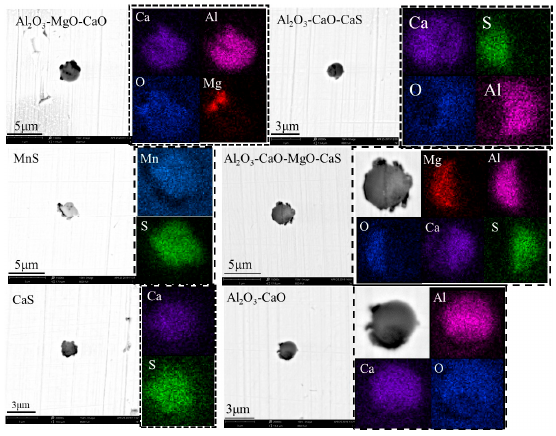
Figure 2. SEM images and energy-dispersive spectroscopy (EDS) maps of the typical inclusions in A1.